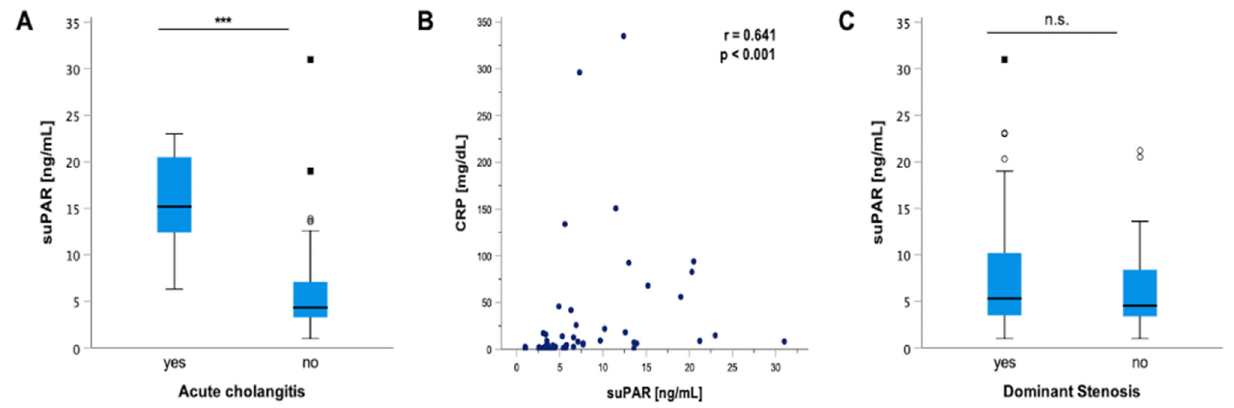
Figure 3. suPAR levels indicate acute cholangitis but not the presence of a dominant stenosis. Our analysis revealed a significant elevation in soluble urokinase-type plasminogen activator receptor (suPAR) levels in patients with acute cholangitis episodes compared to patients without acute cholangitis ( p < 0.001) ( A ). In line with this, Spearman rank correlation showed a positive correlation between circulating suPAR levels and CRP values ( p < 0.001; r = 0.641) ( B ). However, circulating suPAR levels did not indicate the presence of dominant stenosis ( C ). Box plots are displayed, where the bold line indicates the median per group and the edges of the box are the first and third quartiles. The horizontal lines show minimum and maximum values of calculated nonoutlier values. The dots represent calculated outliners. Soluble urokinase-type plasminogen activator receptor (suPAR). (*** p < 0.001).